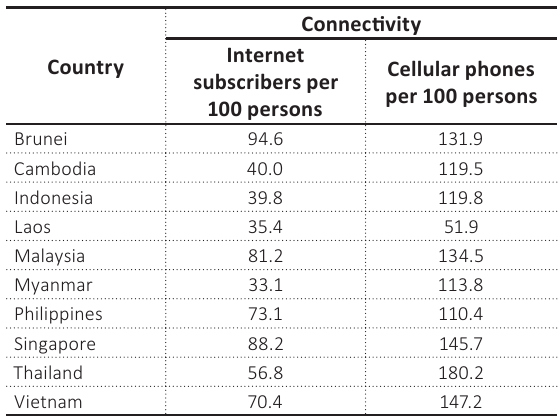
Table 6. Digital connectivity in AESAN countries